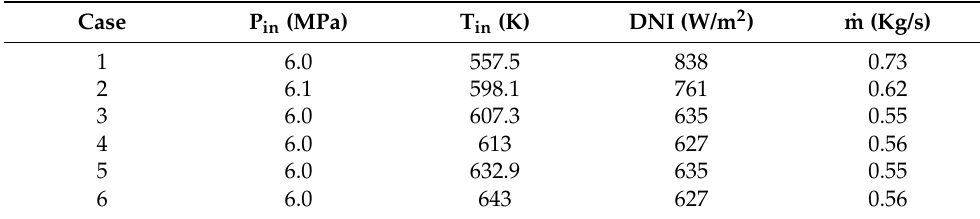
Table 2. Thermal performance test conducted by Rold á n et al.